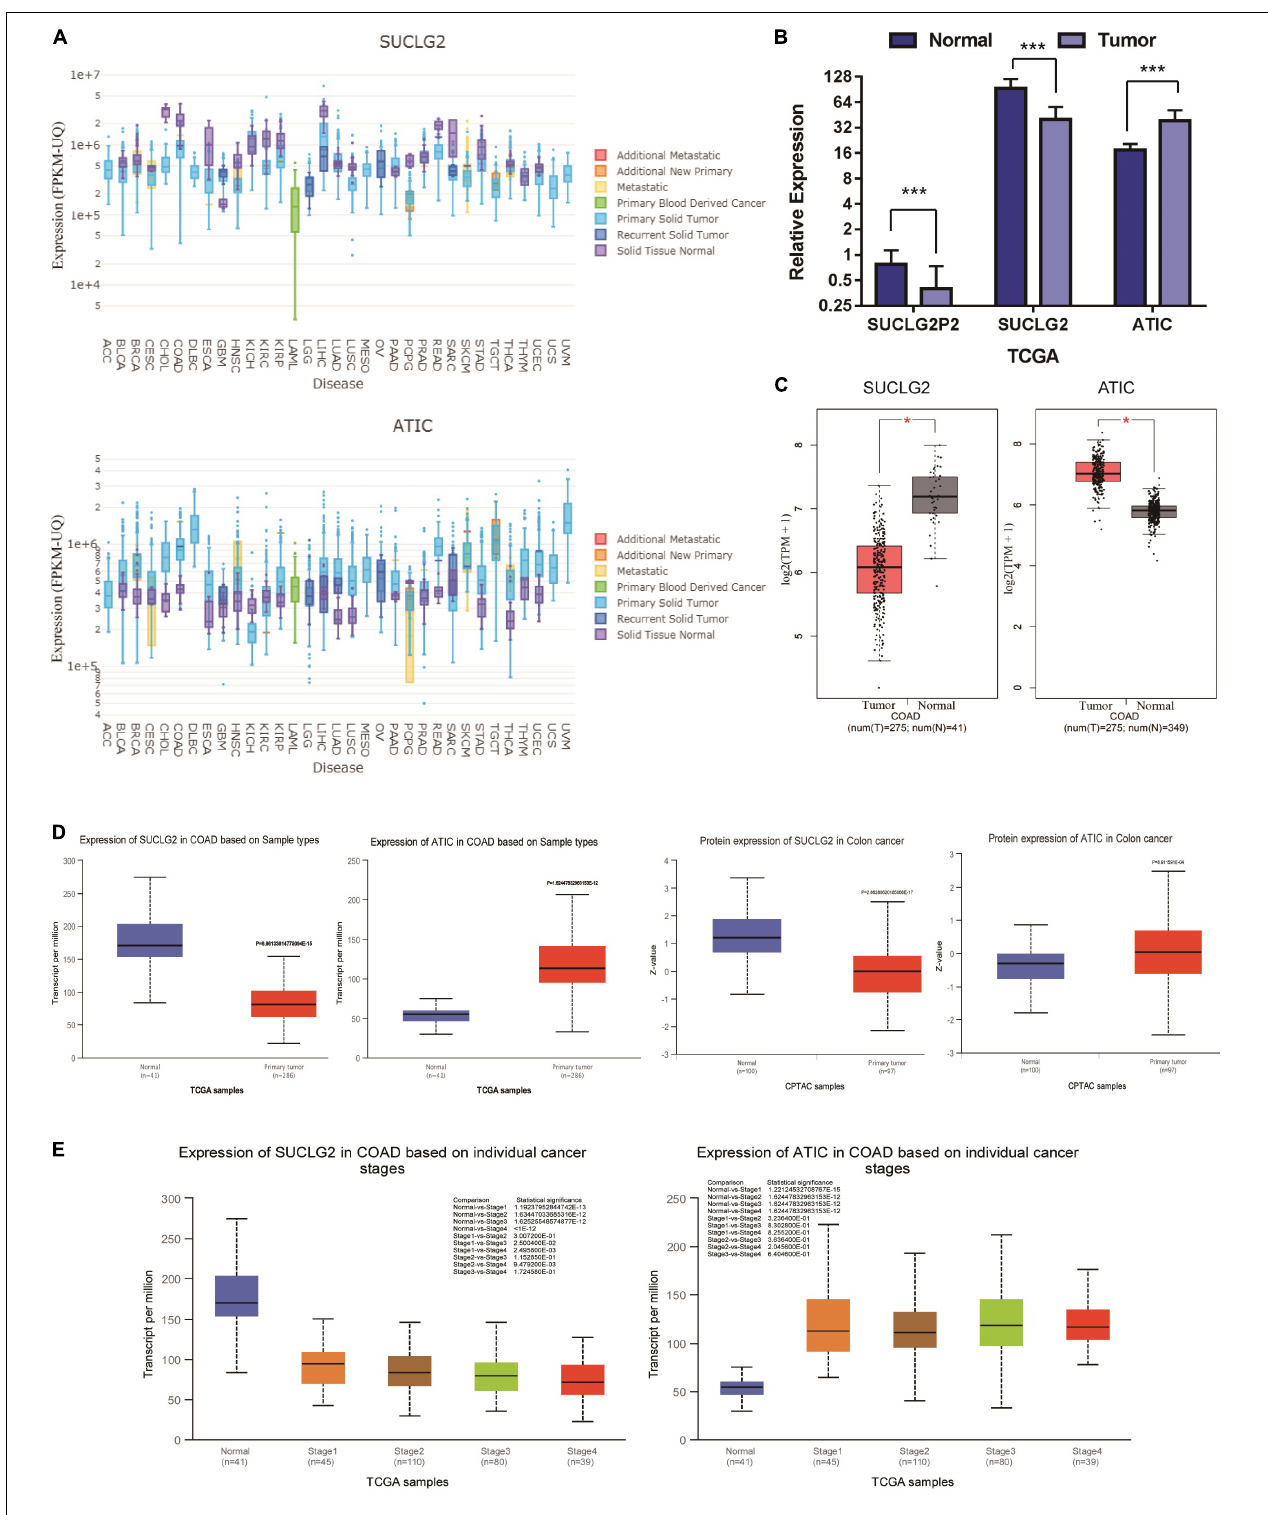
FIGURE 3 | Bioinformational analysis of SUCLG2P2, SUCLG2 and ATIC expression from public Database. (A) The mRNA expression of SUCLG2 and ATIC in pan-cancer. (B) The mRNA expression of SUCLG2P2, SUCLG2 and ATIC in COAD, data is downloaded from TCGA. (C) The mRNA expression of SUCLG2 and ATIC in COAD from GEPIA database. (D) The mRNA and protein expression of SUCLG2 and ATIC in COAD from UACLAN database. (E) The mRNA expression of SUCLG2 and ATIC in different stage of COAD from UACLAN database. *** P < 0.001.